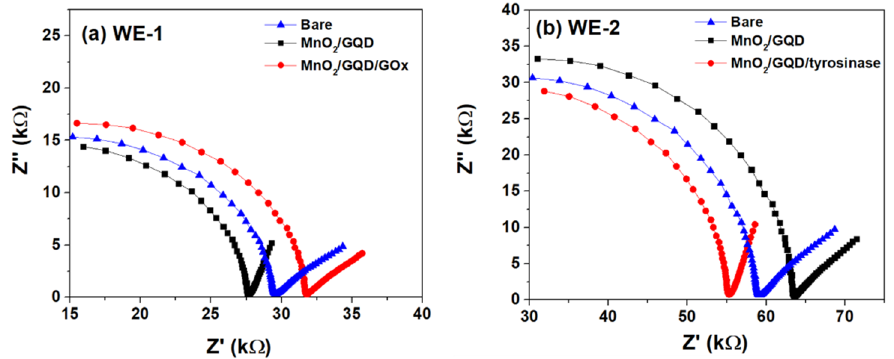
Figure 3. Impedimetric response during various stages of sensor surface modification at ( a ) WE-1; ( b ) WE-2 of the multiplexed strip (WE: working electrode).